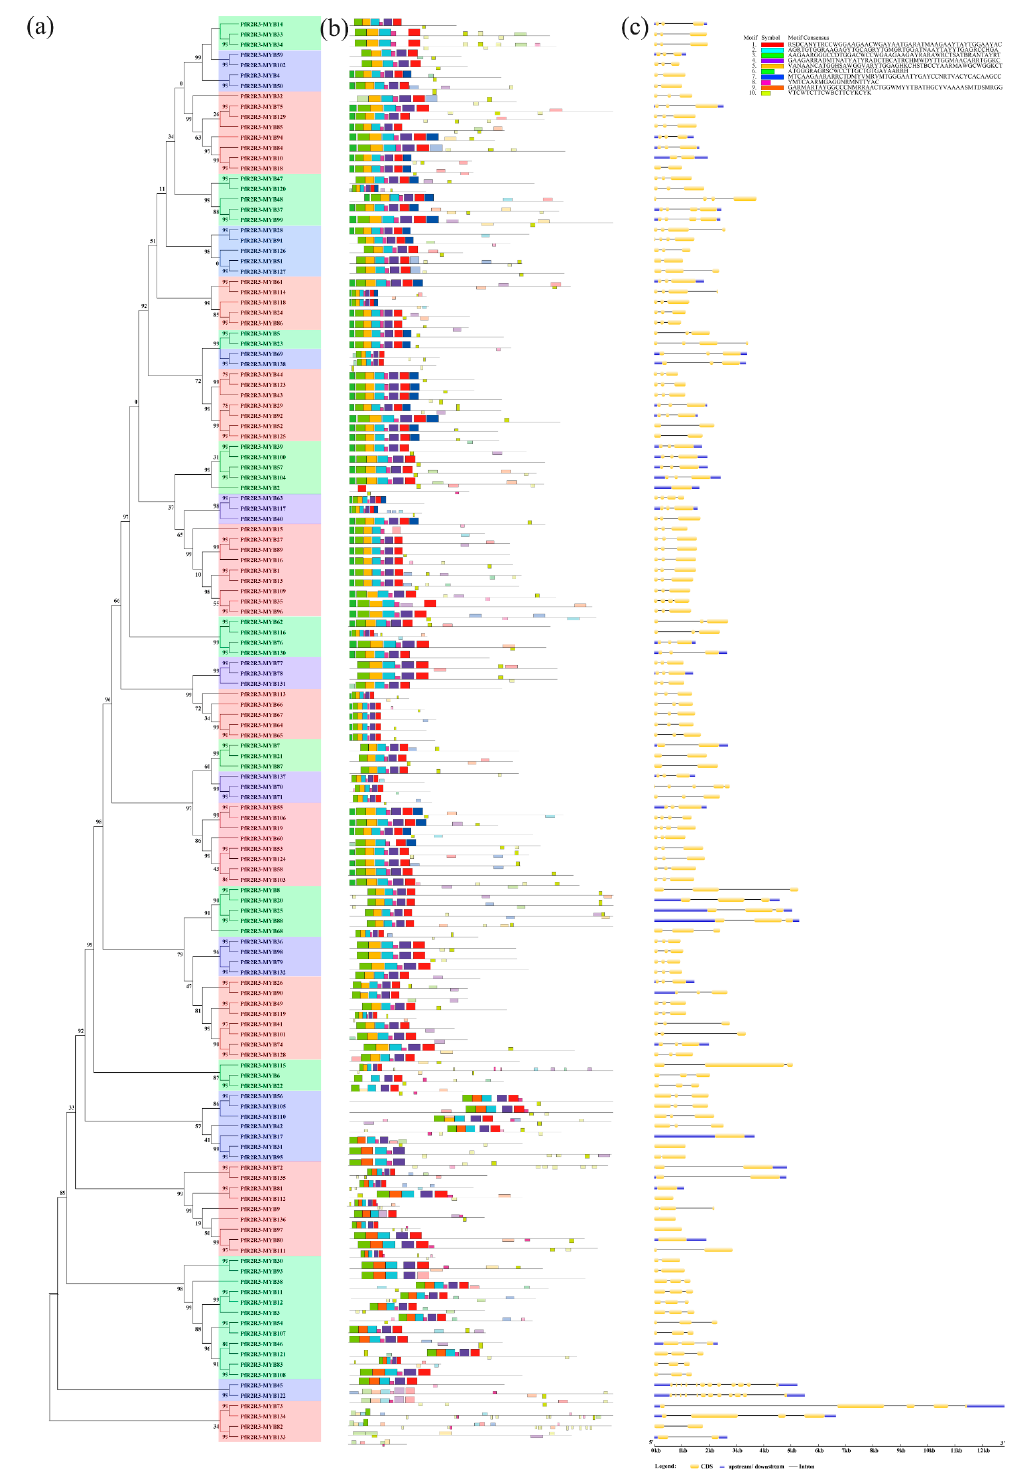
Figure 3. Phylogenetic tree, conserved motifs and gene structures of R2R3-MYB family